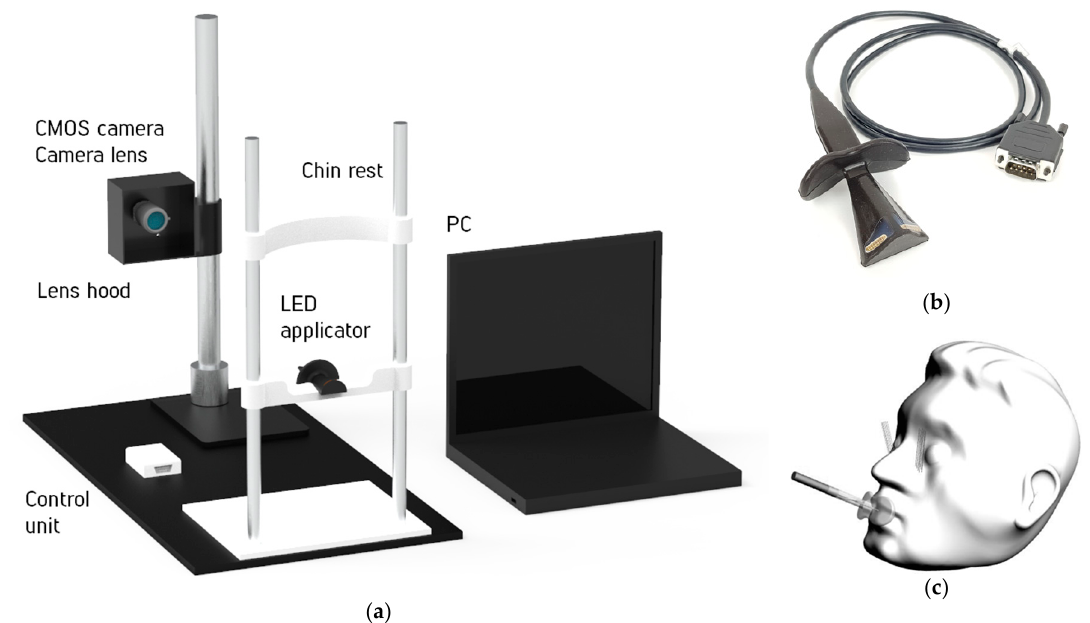
Figure 1. General view of the experimental setup ( a ); the LED applicator (the working part) ( b ); and the position of the applicator during measurement with the propagation of probing rays (3D model) ( c ).